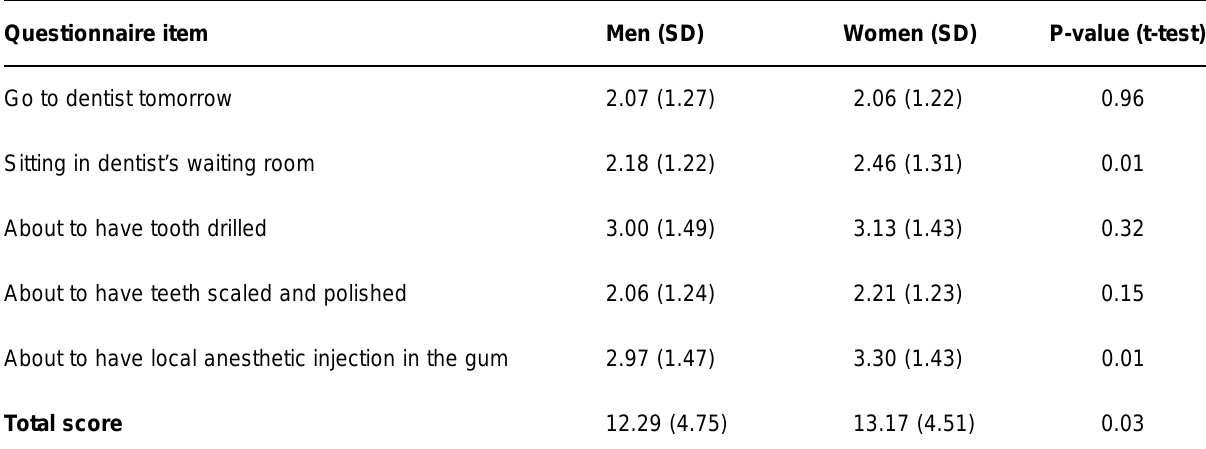
SD = Standard Deviation